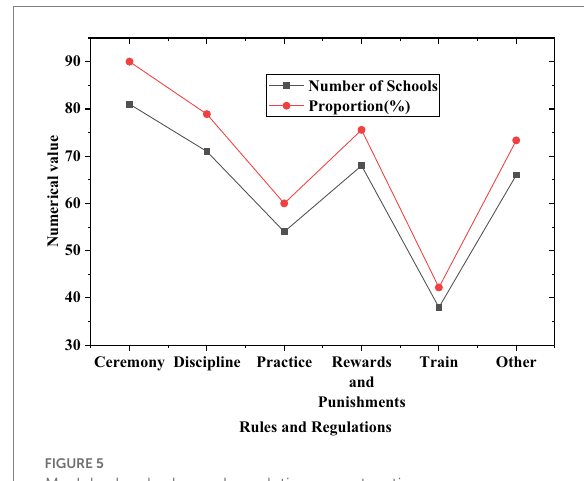
FIGURE 5 Model school rules and regulations construction.